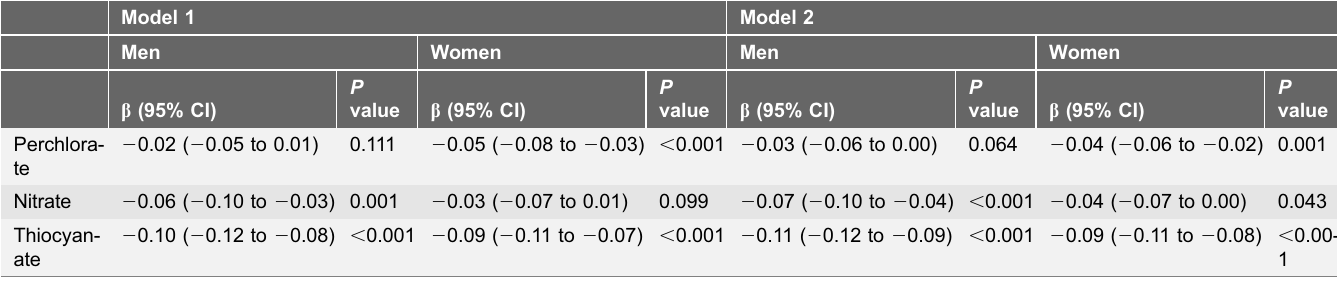
Table 4. Adjusted regression coefficients with 95% confidence intervals (95% CIs) by multiple linear regression analysis for serum parathyroid hormone levels and urinary concentrations of perchlorate, nitrate, and thiocyanate (unadjusted for creatinine) among the United States adults, NHANES 2005–2006.